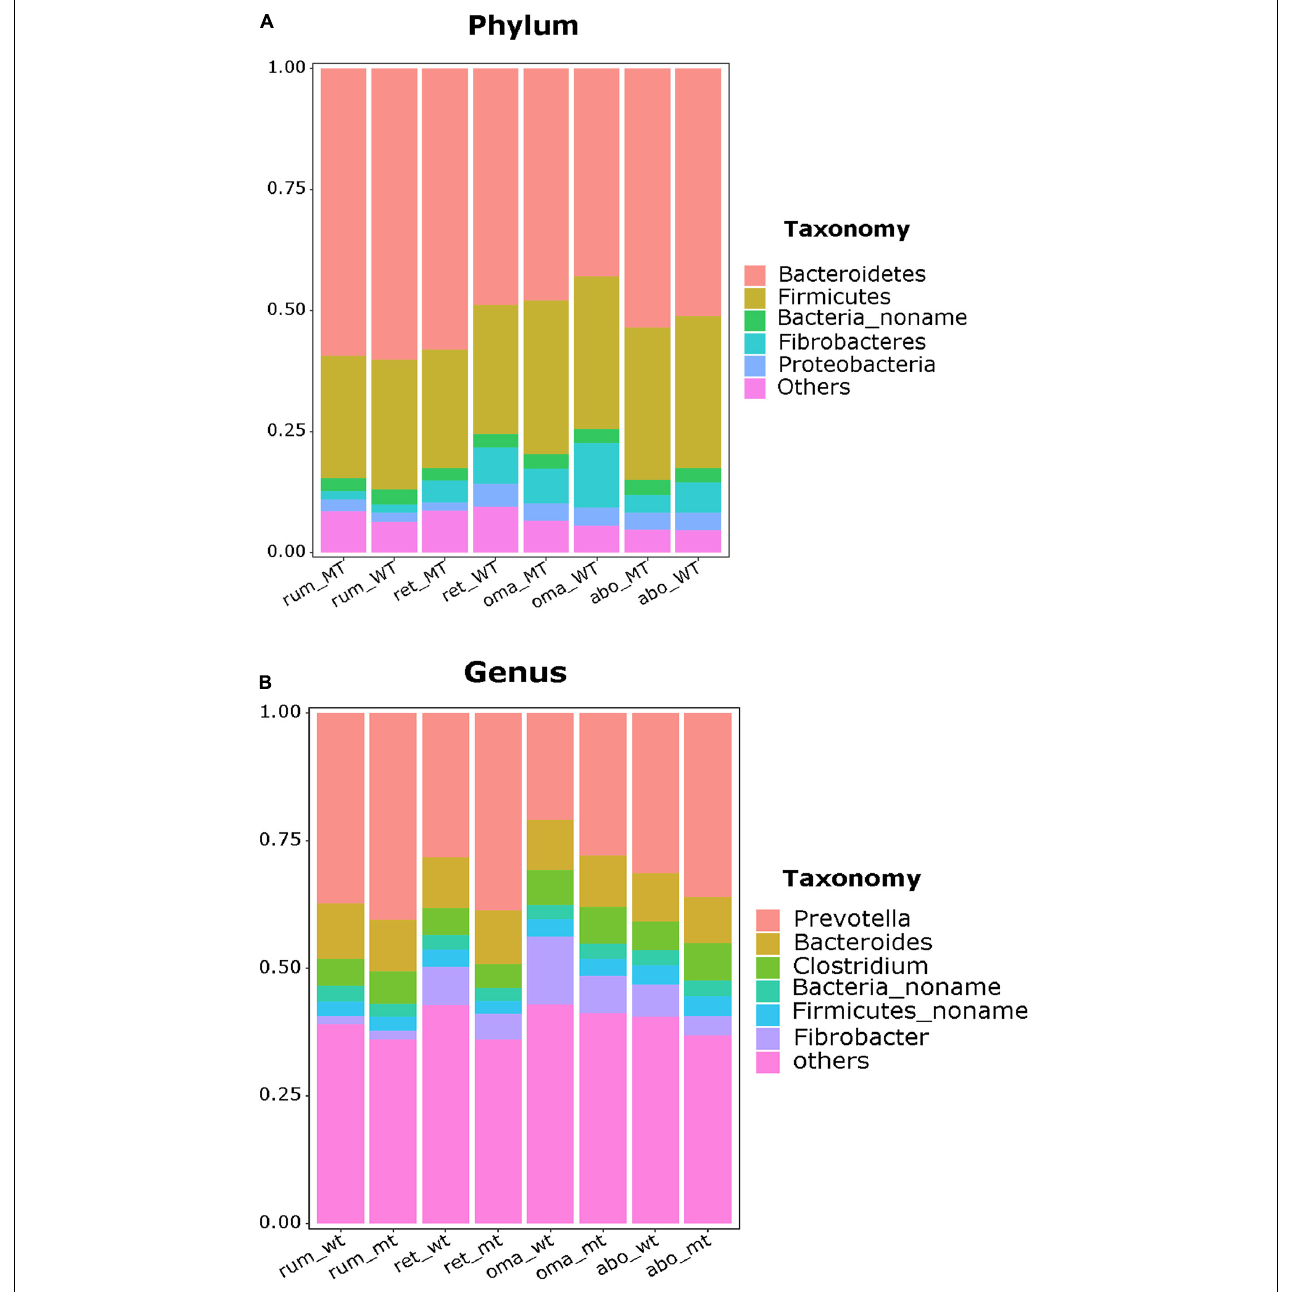
FIGURE 2 | Compositional profiles of the stomach microbiome between MSTN + / − and WT cattle. Bacterial composition at the phylum (A) and genus levels (B) in the rumen, reticulum, omasum, and abomasum.